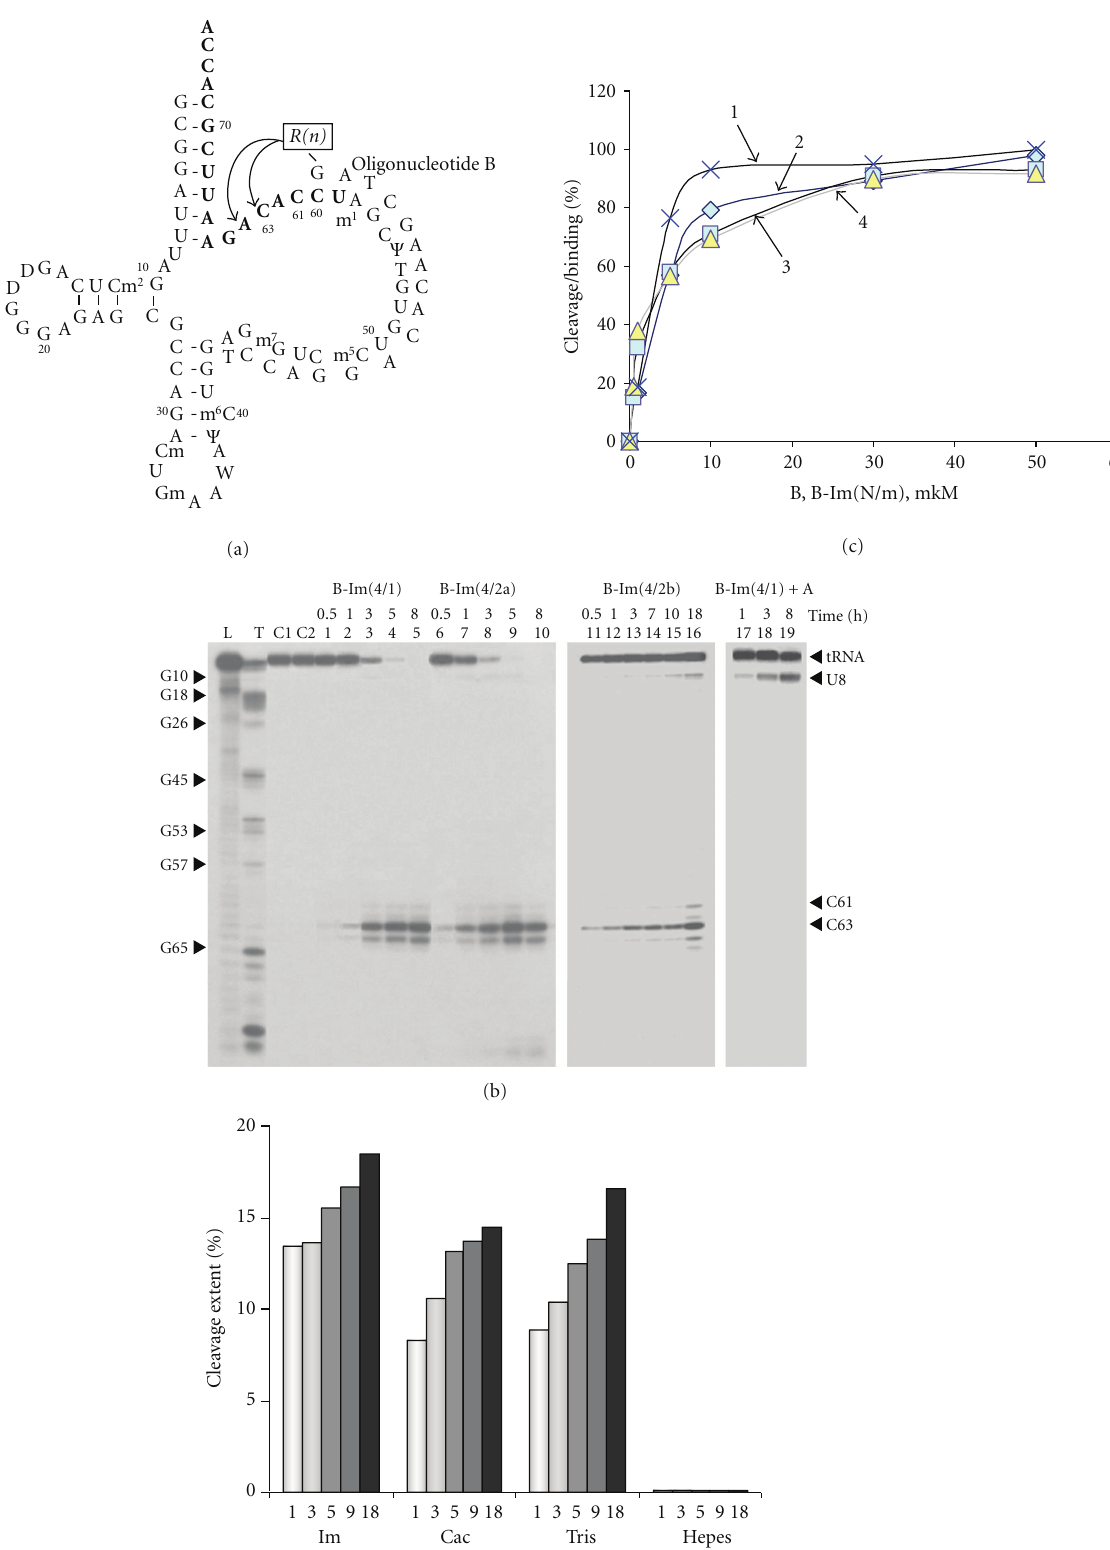
Figure 2: Site-selective cleavage of yeast tRNA Phe by the oligonucleotide conjugates bearing multiple imidazole residues in the catalytic